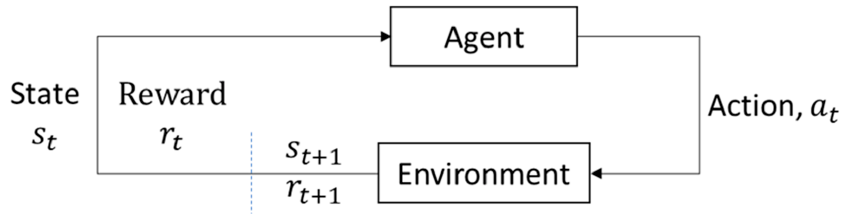
Figure 1. The structure of reinforcement